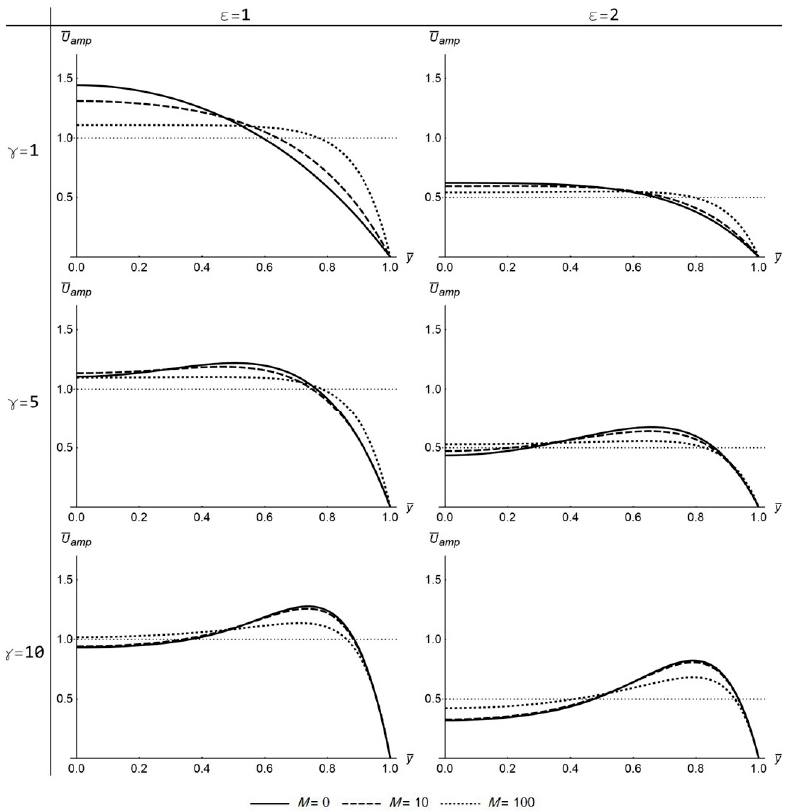
Figure 4. The profiles of U amp under the effect of ε , γ , and M parameters (transverse case). Figure 4. The profiles of 𝑈(cid:4636) (cid:3028)(cid:3040)(cid:3043) under the effect of 𝜀 , 𝛾,𝑎𝑛𝑑 𝑀 parameters (transverse case). Figure 4. The profiles of 𝑈(cid:4636) (cid:3028)(cid:3040)(cid:3043) under the effect of 𝜀 , 𝛾,𝑎𝑛𝑑 𝑀 parameters (transverse case).